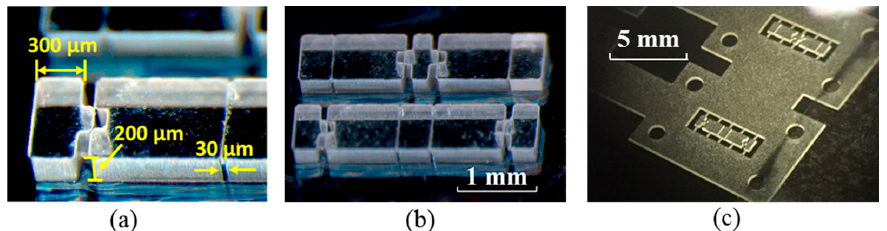
Figure 3. Optical micrographs of ( a ) the 200-µm-thick SU-8 structures (rigid half-scissor linkages for active alignment) with 30-µm microfabricated gaps for hinge bending; ( b ) the upper and lower